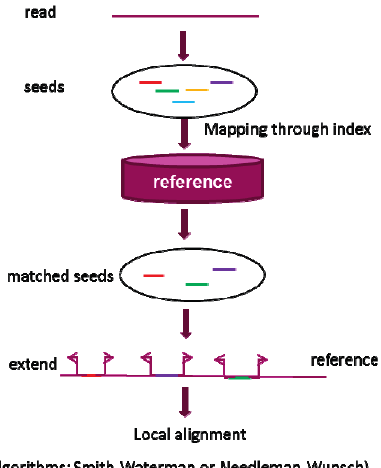
Figure 2. A brief workflow of seed-and-extend strategy in alignment. Generally, the strategy can be divided into three steps: (1) generate raw seed from a read; (2) identify the matched seed; and (3) extend the matched seed and do the local alignment through standard dynamic programming algorithms based on Needleman–Wunsch (NW) [78] algorithm or Smith–Waterman (SW) algorithm